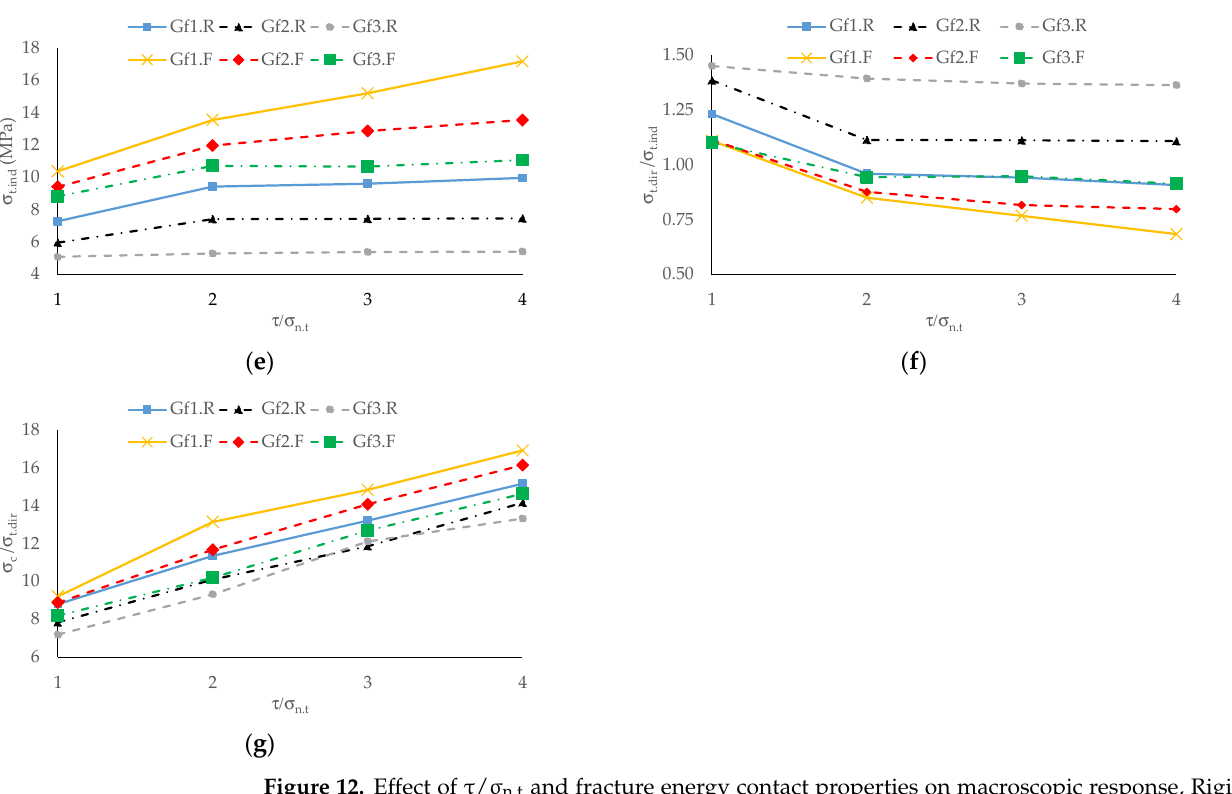
Figure 12. Effect of τ / σ n.t and fracture energy contact properties on macroscopic response, Rigid (R) and Flexible (F) numerical predicted response: ( a ) compression strength; ( b ) friction angle; ( c ) cohesion; ( d ) direct tensile strength; ( e ) indirect tensile strength; ( f ) direct to indirect tensile strength ratio and ( g ) compression to direct tensile strength ratio.